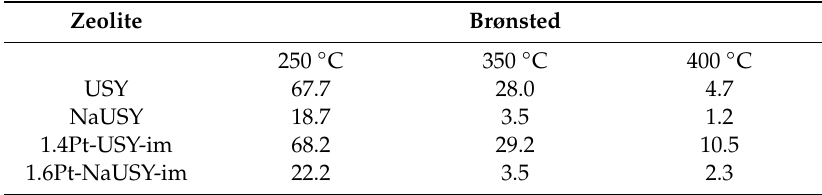
Table 3. Density of Brønsted acid sites ( µ mol / g) determined by FTIR spectroscopy of adsorbed pyridine at 250, 350, and 400 ◦ C.